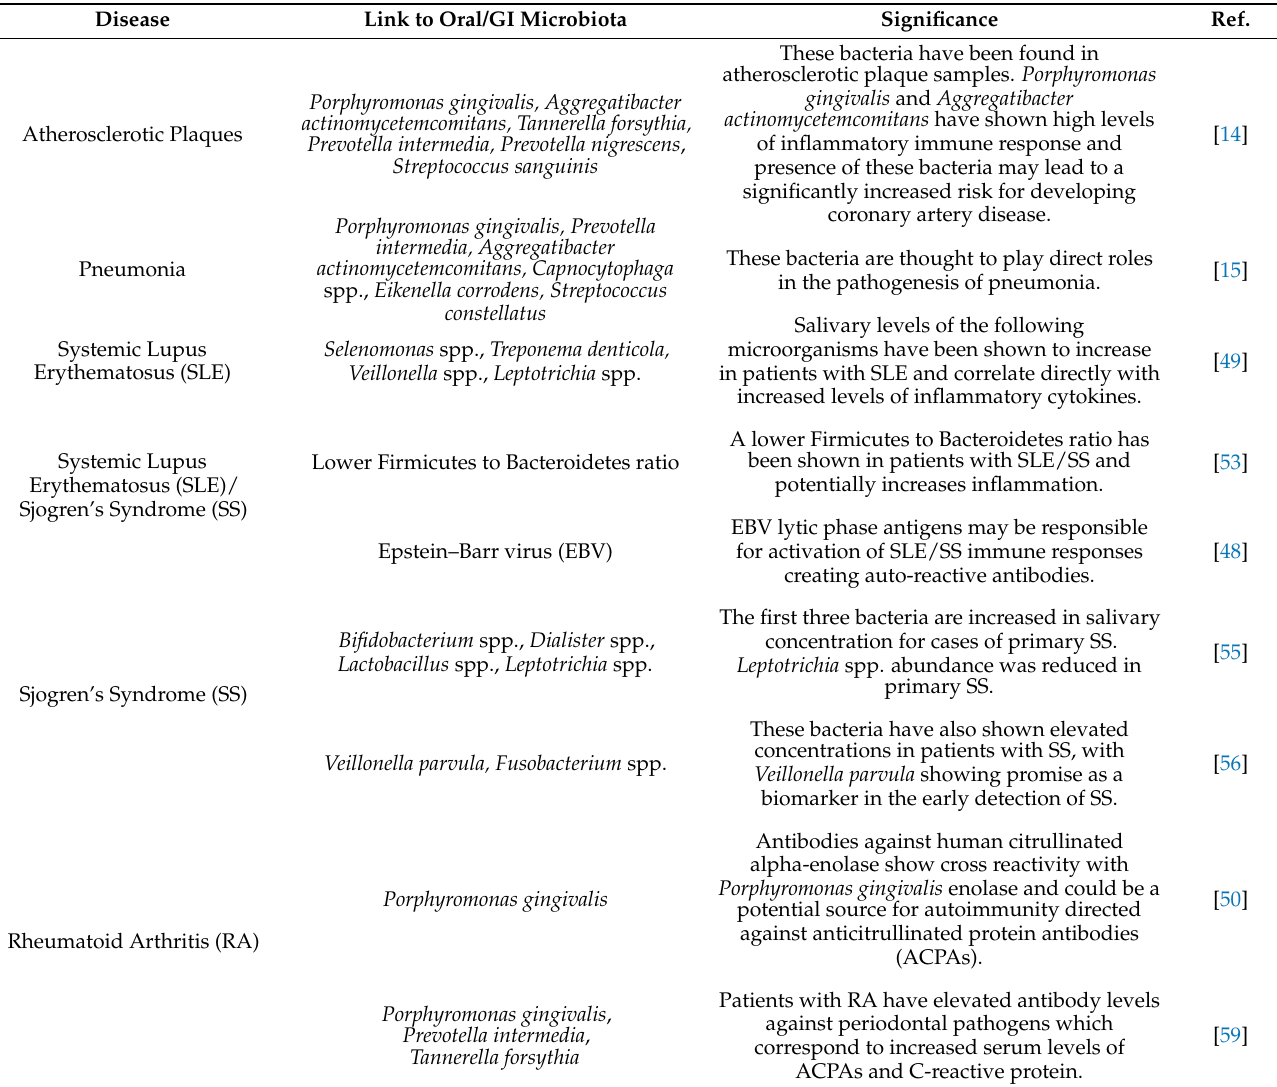
Table 3. Link between and significance of oral and GI microorganisms and specific systemic diseases.